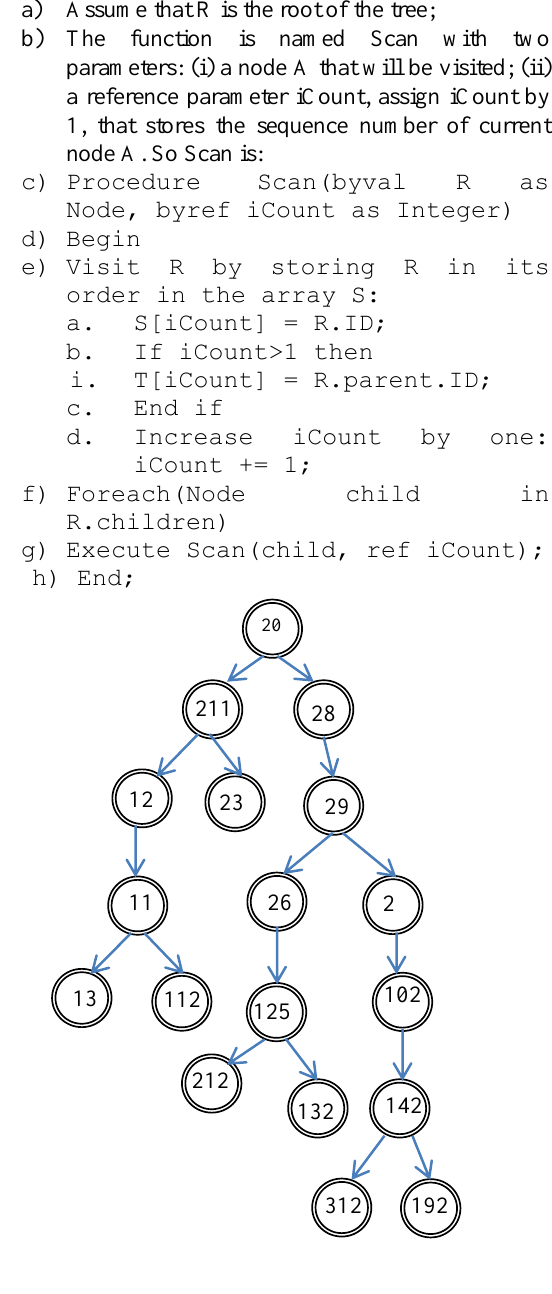
Figure 7. An example of multicast